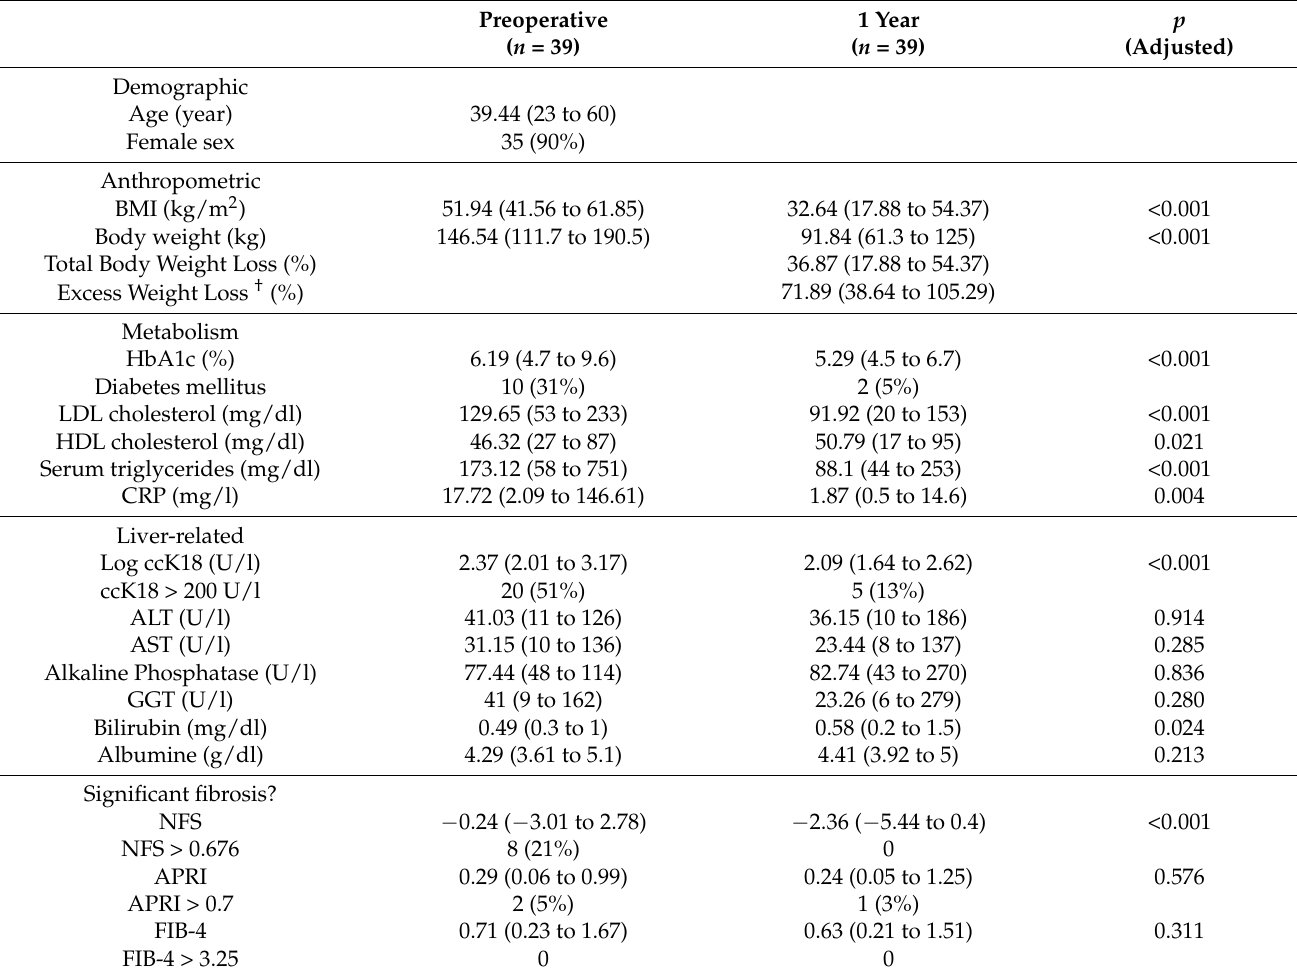
Table 1. Baseline parameters of the full cohort before and one year after